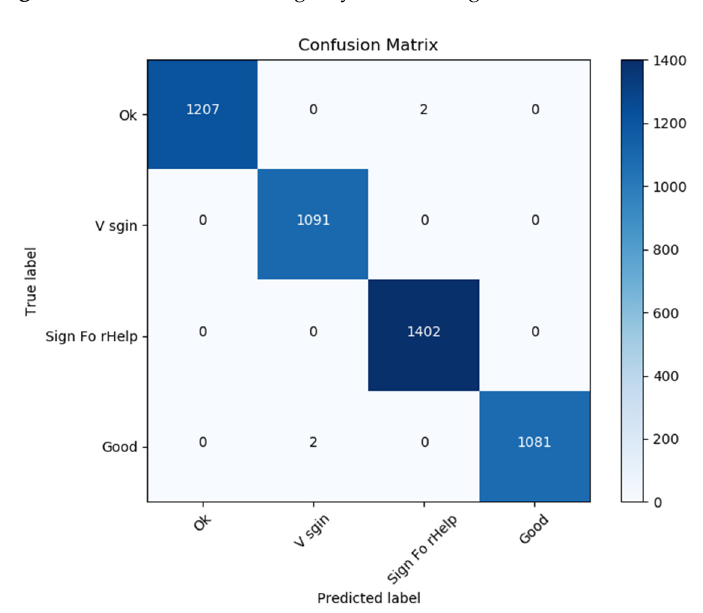
Figure 14. Confusion matrix with predicted labels on X -axis and true labels on the Y -axis tested in the testing set.